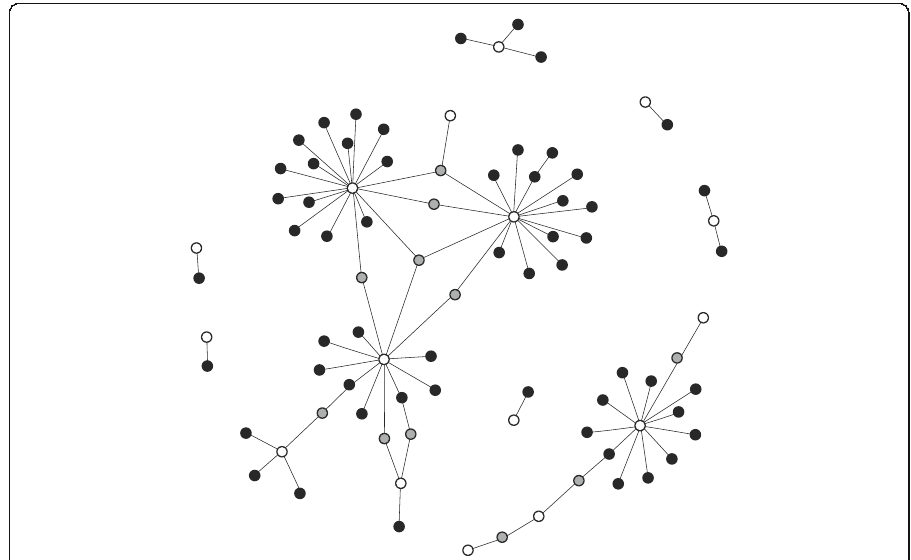
Fig. 5 Network diagram of the interaction of fishers with people who buy fish. Black = single trade relationship, grey = multiple traders and white = traders. This network diagram highlights the emerging property of organised fishing businesses that are dependent on the access to capital. From Kininmonth et al.